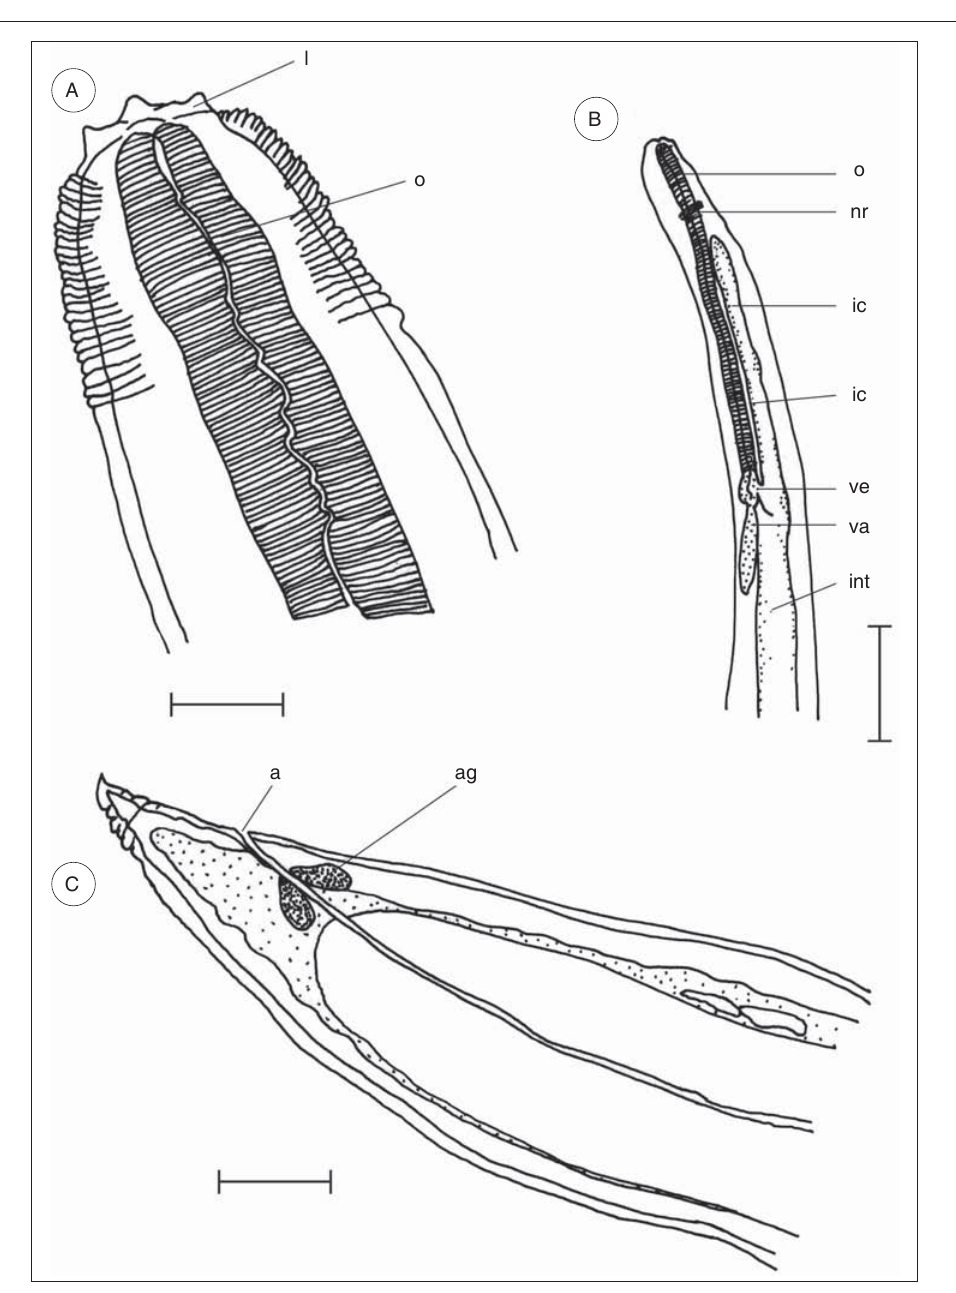
FIG. 4 Contracaecum sp. Larvae. (A) head. Scale bar = 200 μ m; (B) anterior end showing ventricu- lar region. Scale bar = 500 μ m; (C) posterior end. Scale bar = 200 μ m. a = anus, ag = anal glands, ic = intestinal caecum, int = intestine, l = lip (labium), nr = nerve ring, o = oesopha- gus, va = ventricular appendix, ve =